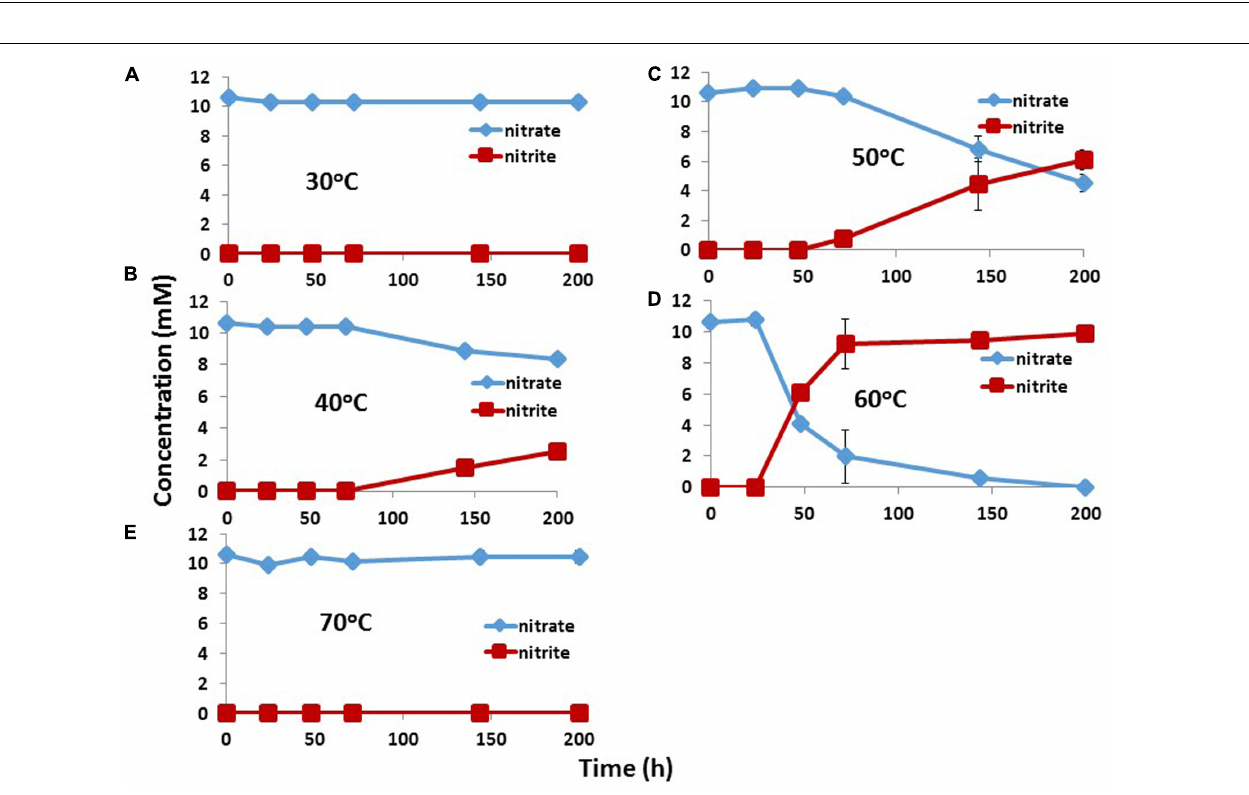
FIGURE 4 | Effect of incubation temperature on nitrate reduction by a pure culture isolate Geobacillus sp. TK004, obtained from IW1\_14. Data are averages for duplicate incubations; standard deviations are shown. The medium contained 3 mM VFA and 10 mM nitrate. 30 ◦ C (A) , 40 ◦ C (B) , 50 ◦ C (C) , 60 ◦ C (D) , and 70 ◦ C (E) .